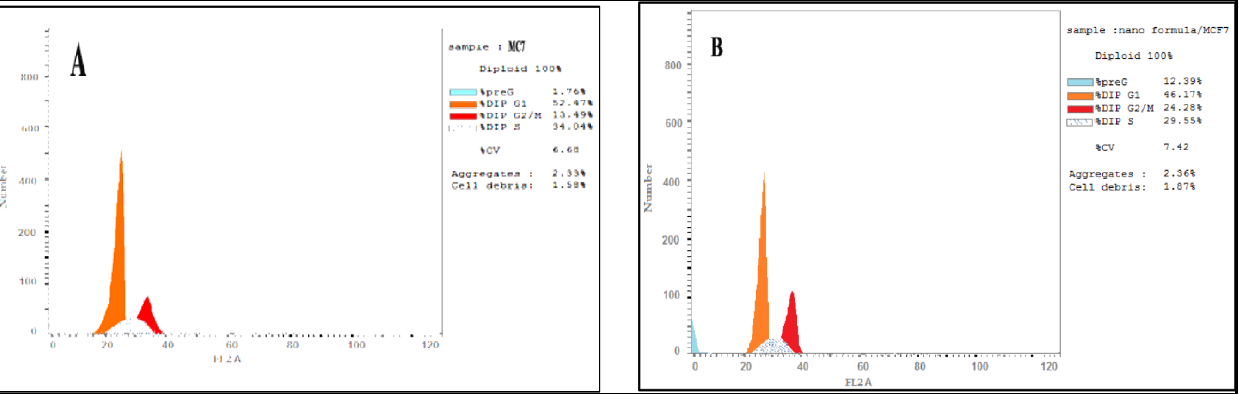
Figure 8. ( A ) Cell cycle analysis for MCF-7 cancer cell line (control). ( B ) Cell cycle analysis for MCF-7 cancer cell line was treated with CA-BSA-NPs.